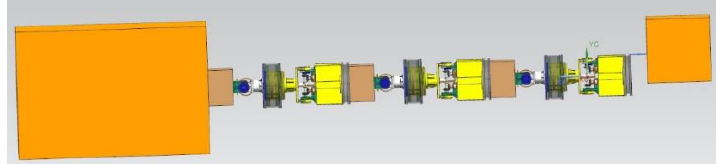
Figure 5. The space manipulator structure model. Table 1. The dynamic parameters of the space robot